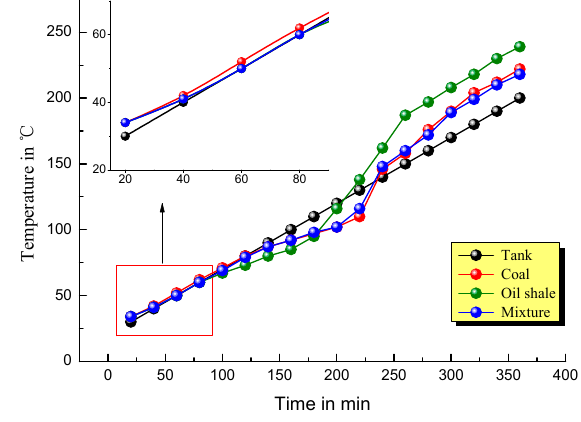
Figure 2. Relationship between temperature and time in the programmed heating experiment.